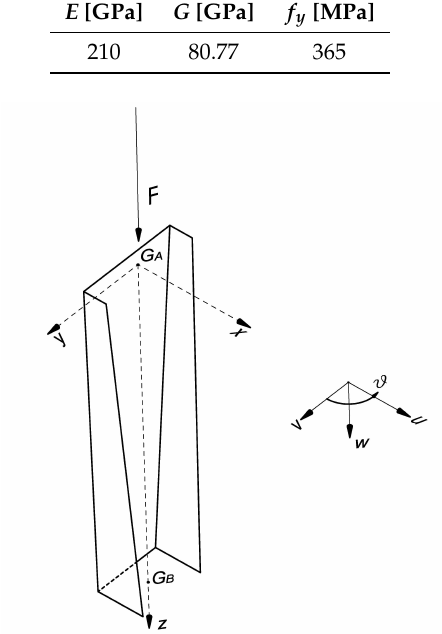
Figure 1. Schematic of the analyzed beam and basic